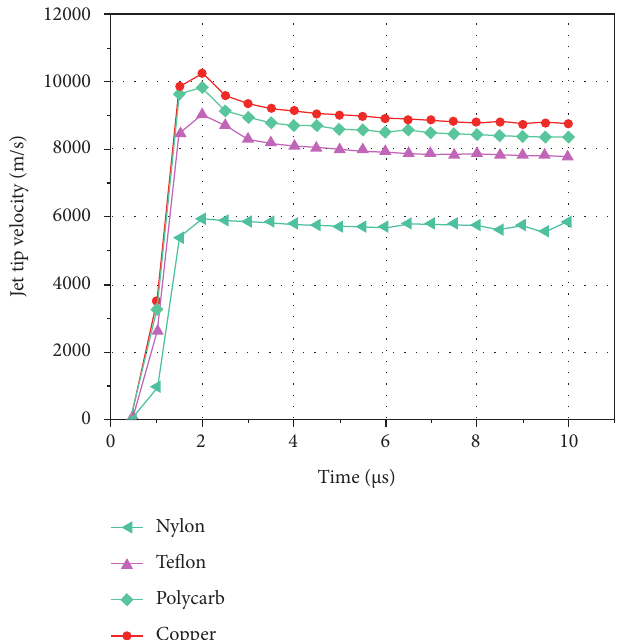
Figure 4: Jet tip velocity corresponding to the four different material